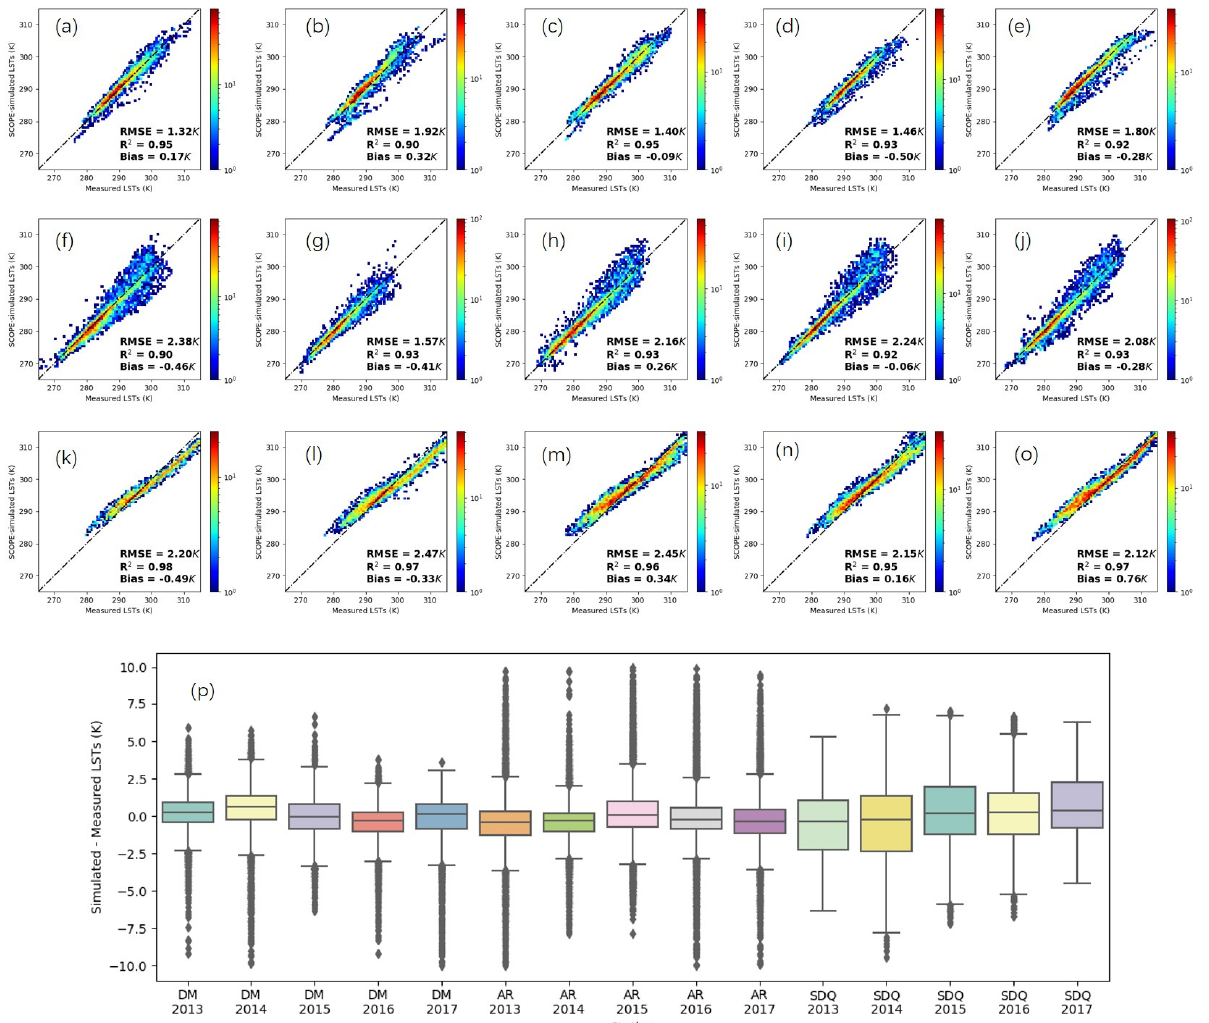
Figure 7. Scattering plots between measured and SCOPE-simulated brightness temperatures at three super Scheme from 2013 to 2017. ( a – e ) correspond to cases at DM station. ( f – j ) correspond to cases at AR station. ( k – o ) correspond to cases at SDQ station. ( p ) The boxplots of differences between SCOPE-simulated and measured brightness temperatures.